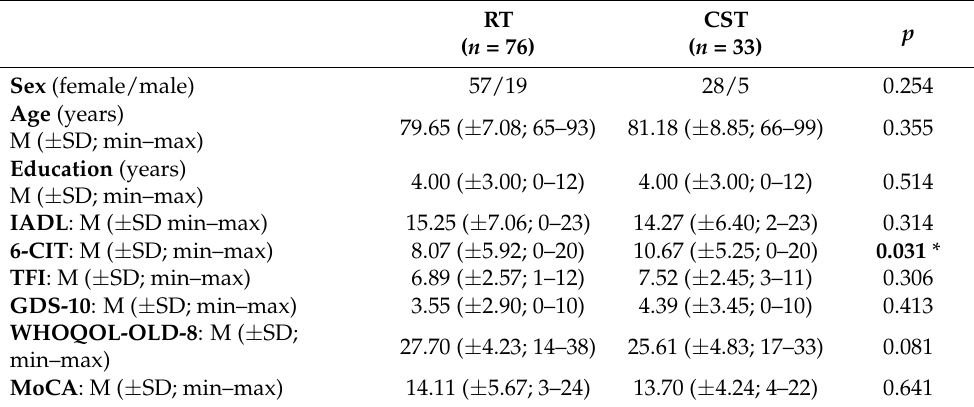
Table 1. Characterization of the participants who integrated the T1 assessment in the RT and CST groups ( n =